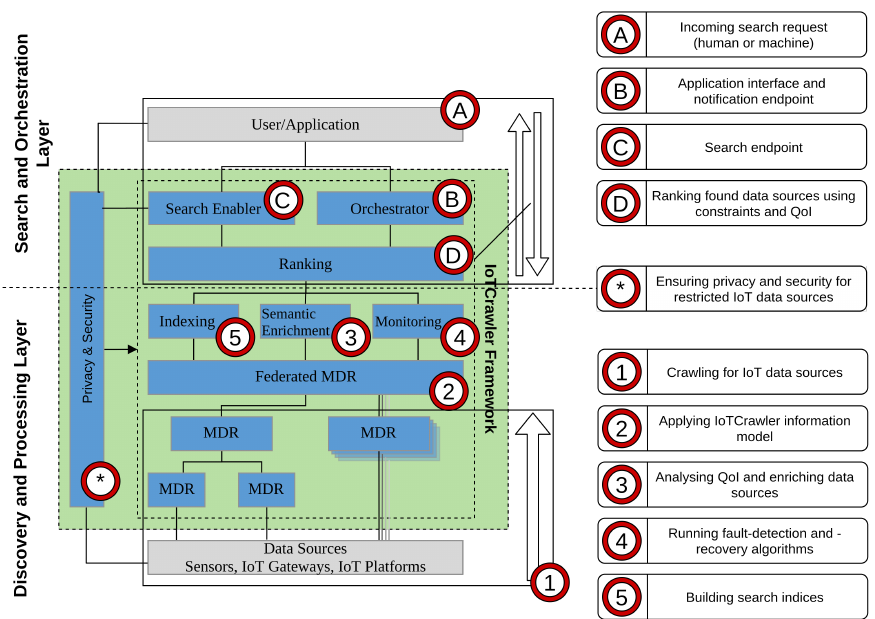
Figure 1. IoTCrawler addressing search in Internet of Things